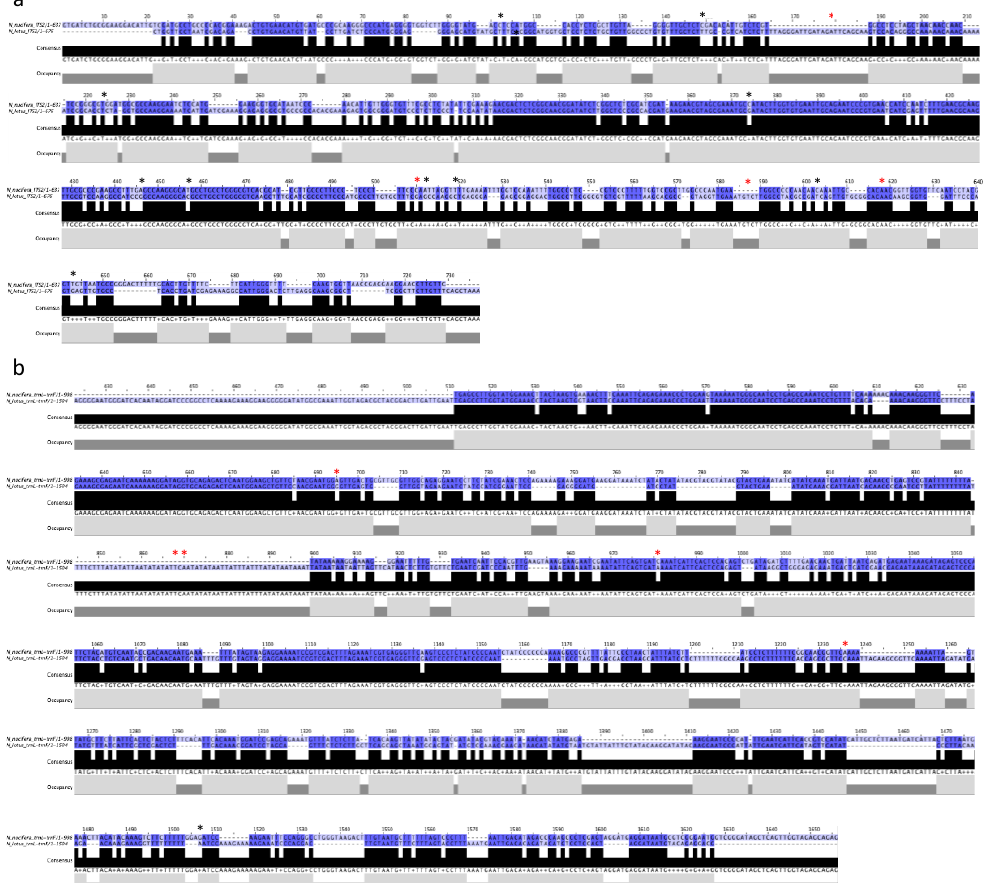
Figure 2. DNA sequence alignments showing consensus and occupancy for the nuclear internal transcribed spacer 1 ( ITS1 ) ( a ) and the chloroplast tRNA-Leu-tRNA-Phe ( trn L- trn F) intergenic spacer ( b ) from N. nucifera vs. N. lotus. Intraspecific variable positions are indicated by * (red) for N. nucifera and * (black) for N. lotus.